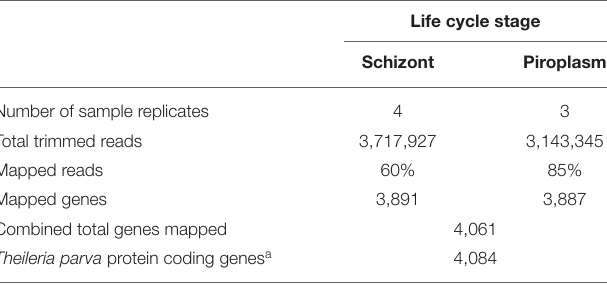
TABLE 1 | Percentage of reads mapped to the reference genome transcriptome using Kallisto and number of mapped genes.